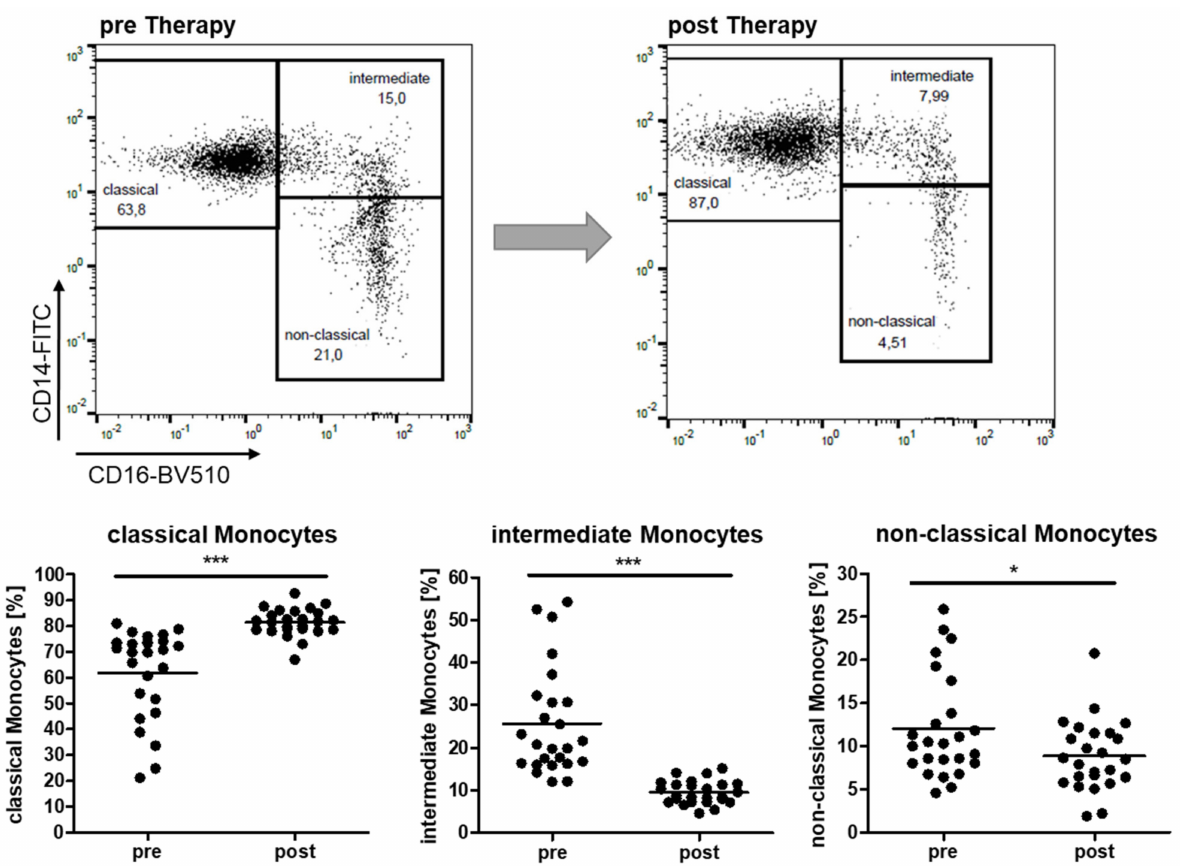
Figure 1. Flow cytometric analysis of CD14- and CD16-characterized monocyte subsets. Shown are analyses of one representative patient before and after 6 months PAP therapy. Dot plots show percentages of classical, intermediate and non-classical monocytes before (pre) and after (post) therapy. n = 25. *: p < 0.05; and ***: p <